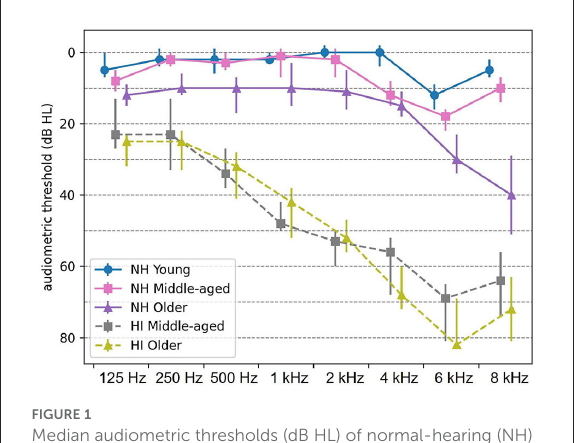
FIGURE1 Median audiometric thresholds (dB HL) of normal-hearing (NH) and hearing-impaired (HI) participants, averaged across both ears. Thresholds are indicated by circles, squares, and triangles for young, middle-aged, and older persons, respectively. Error bars indicate the interquartile range. NH, normal hearing; HI, hearing